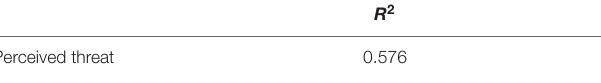
TABLE 6 | Assessment of R